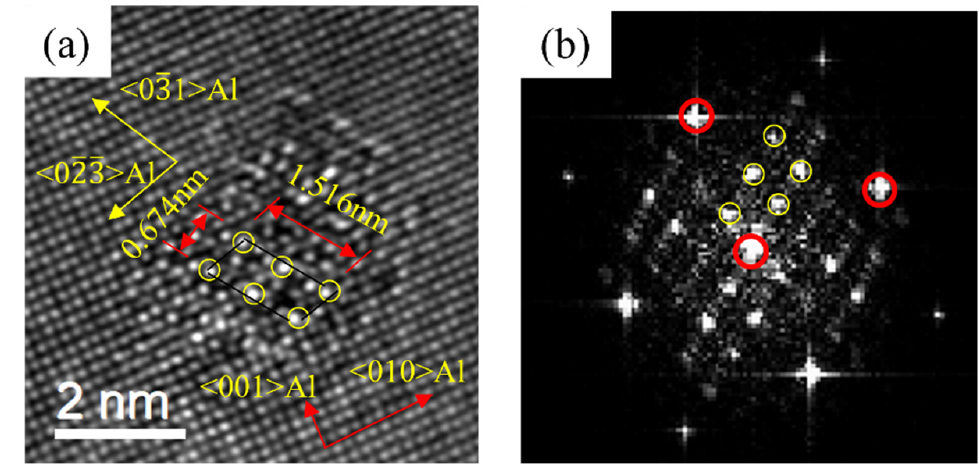
Figure 10. HRTEM ( a ) and FFT ( b ) patterns of the β″ phase of 0.18Cu alloy after peak aging at 175 °C for 10 h.